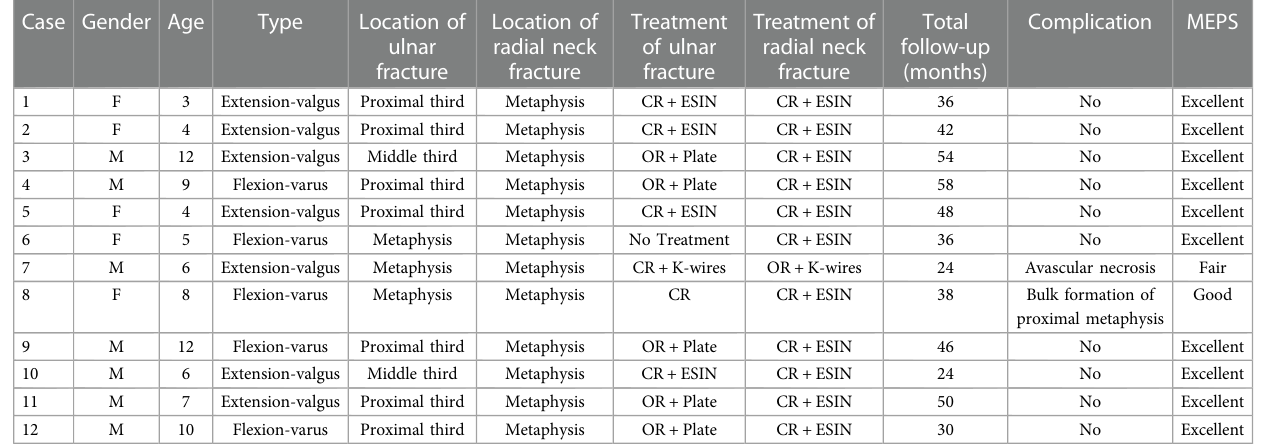
TABLE 1 The details of patients and treatment